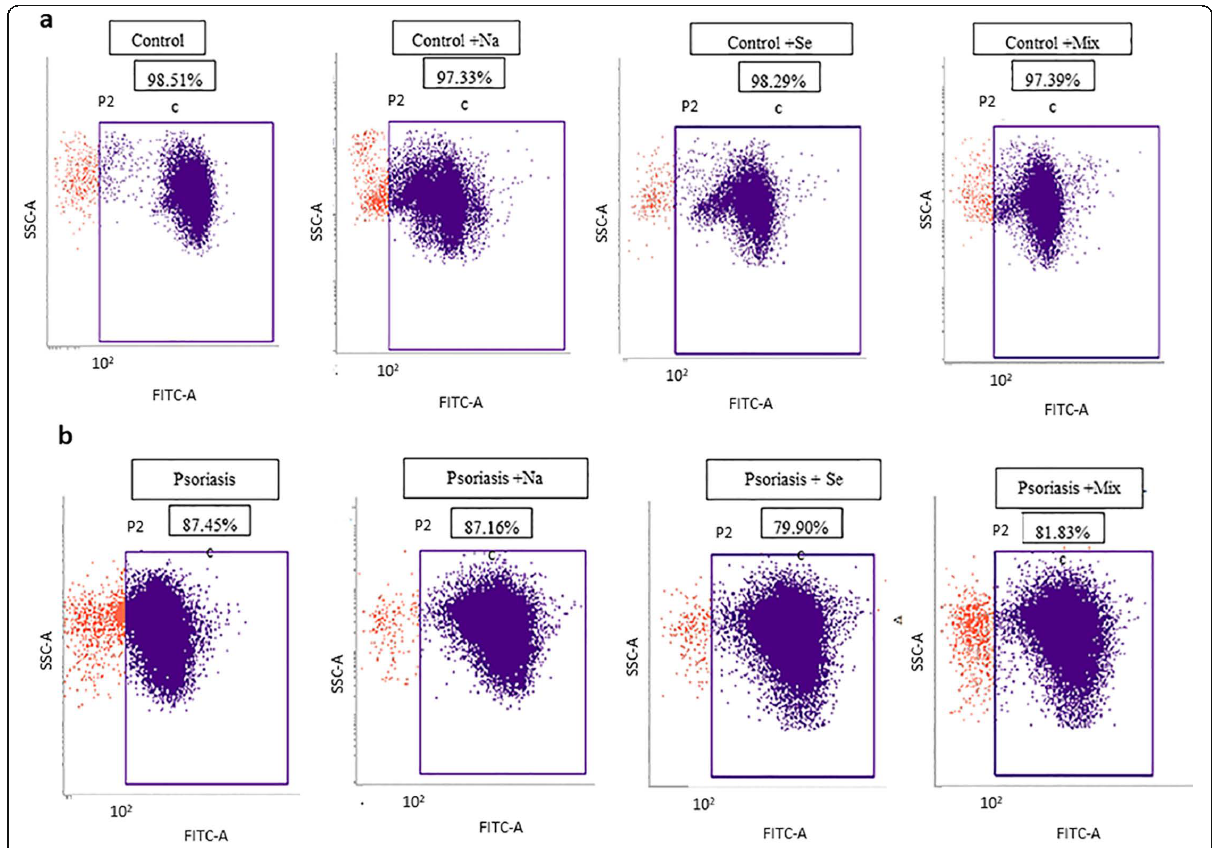
Fig. 2 The viability of the hPBMC (measured by flow cytometry) isolated from blood of healthy subjects (control) ( a ) and psoriasis patients ( b ) following exposure to 20 μ g/ml Naringin (Na), 100 μ g/ml Sericin (Se), and Naringin/Sericin mixture 20/100 μ g/ml compare with control (hPBMC from healthy subjects or psoriasis patients without exposure)